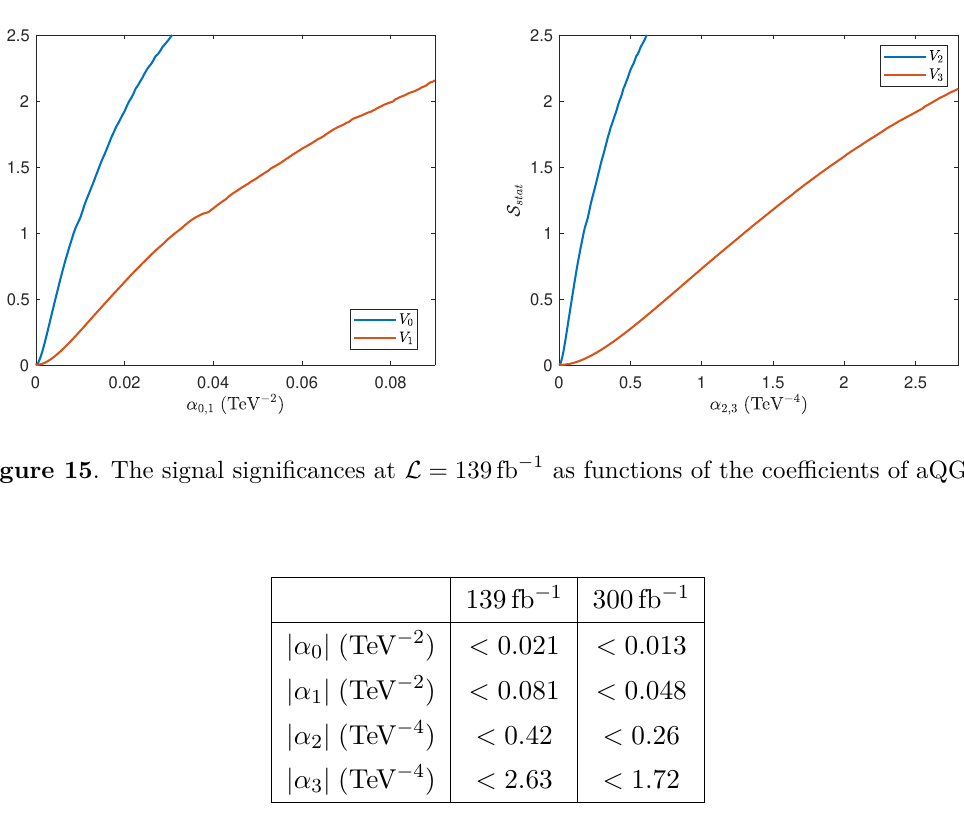
Table 5 . The expected constraints on the coefficients of the anomalous γγWW couplings at 13 TeV with L = 139 fb − 1 and L = 300 fb − 1 when S stat < 2